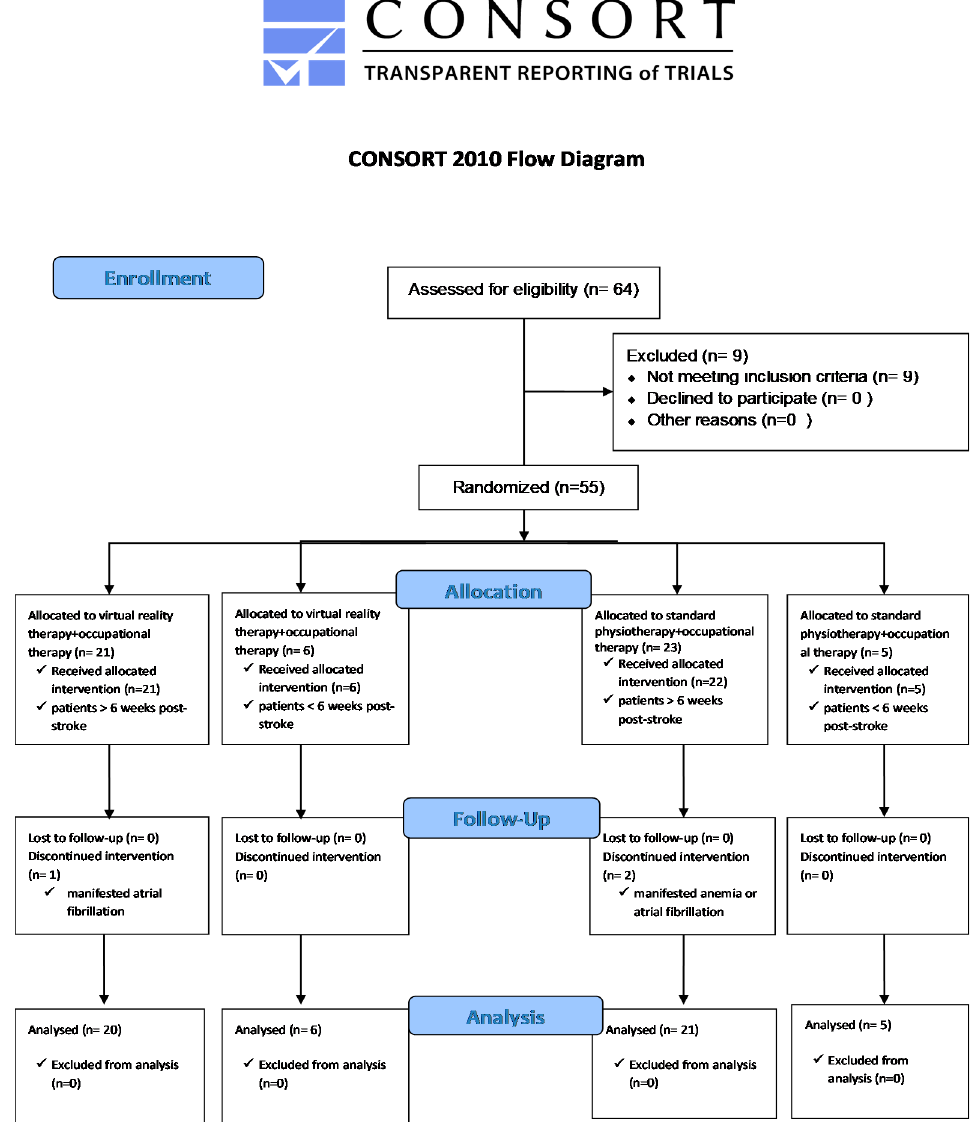
Figure 1. The CONSORT flow diagram.